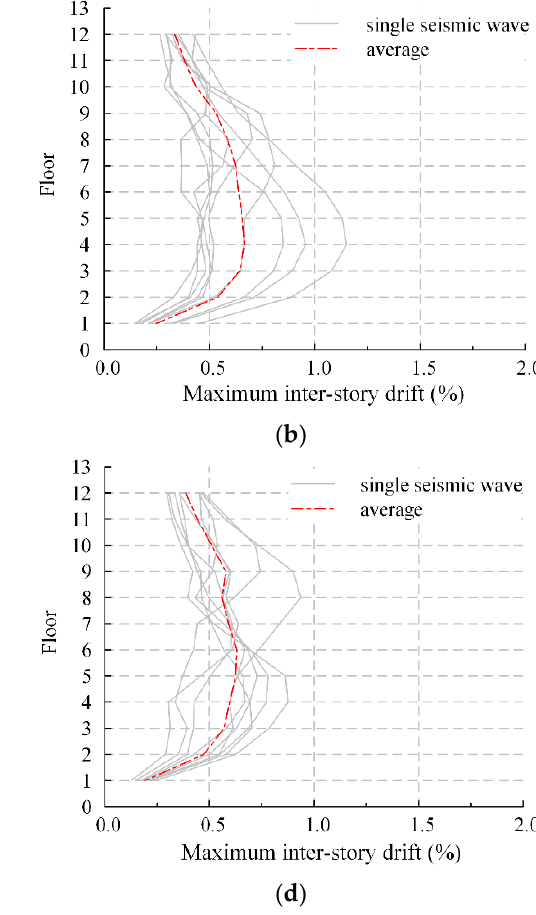
Figure 17. Average maximum inter-story drift of the four-story PCF-BRB structure: ( a ) changes and ( b ) average ratio.